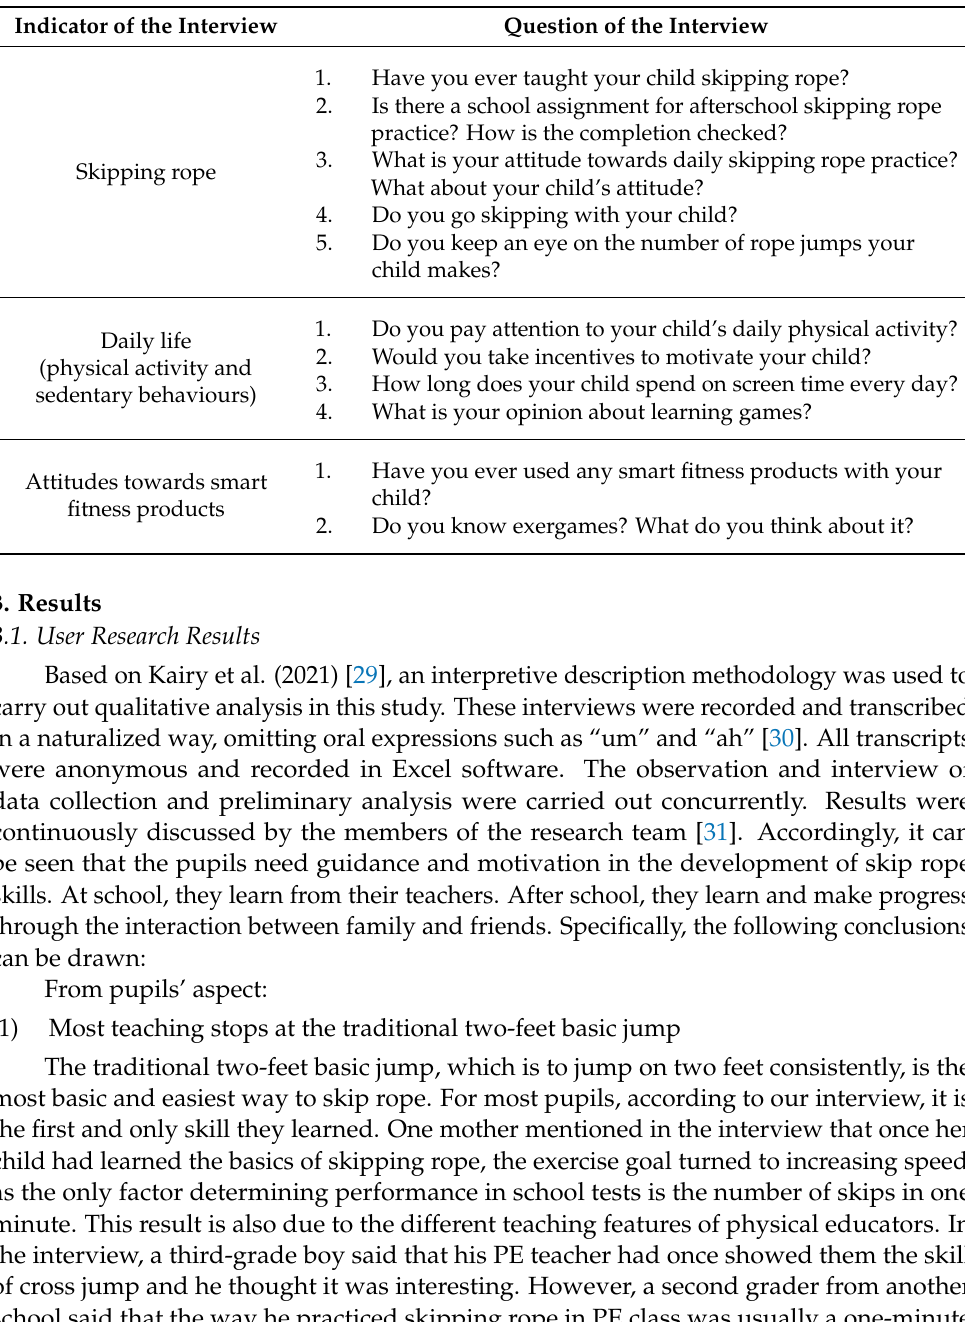
Table 2. List of the questions used in interviews with the